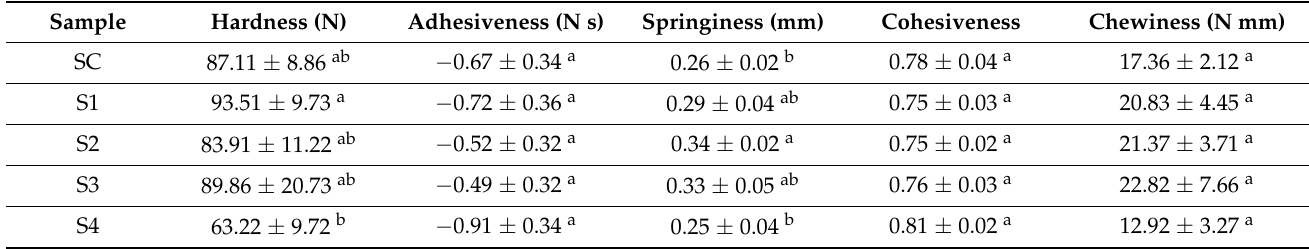
Table 5. Effect of partial and total replacement of pork back fat by the gelled emulsion from hemp oil and buckwheat flour, on texture profile of